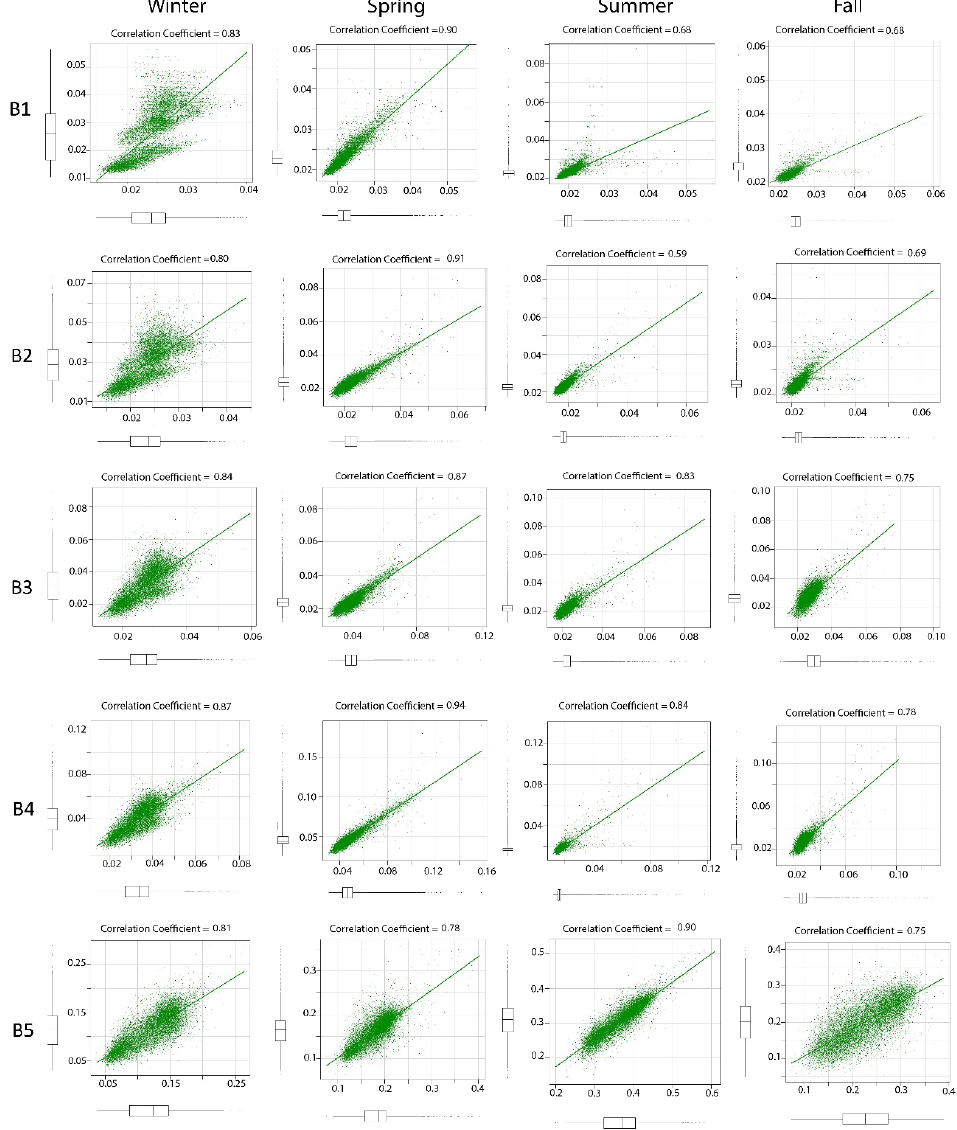
Figure 3. Scatterplots of each band per season ( x-axis depicts Landsat while y-axis depicts Sentinel data) .